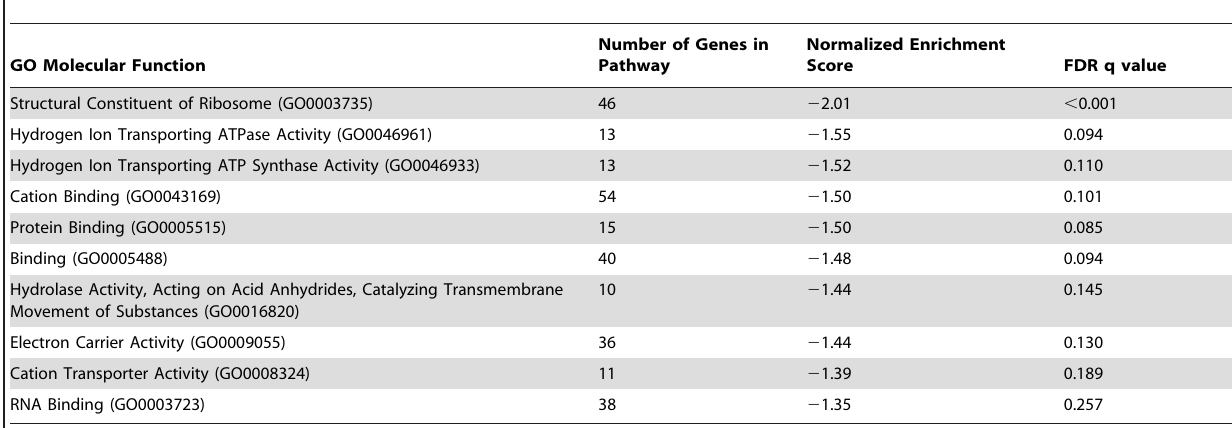
Table 1. GO Molecular Functions that are Enriched with Genes Downregulated in B. theta from Monoassociated HLA-B27 Tg Rats.